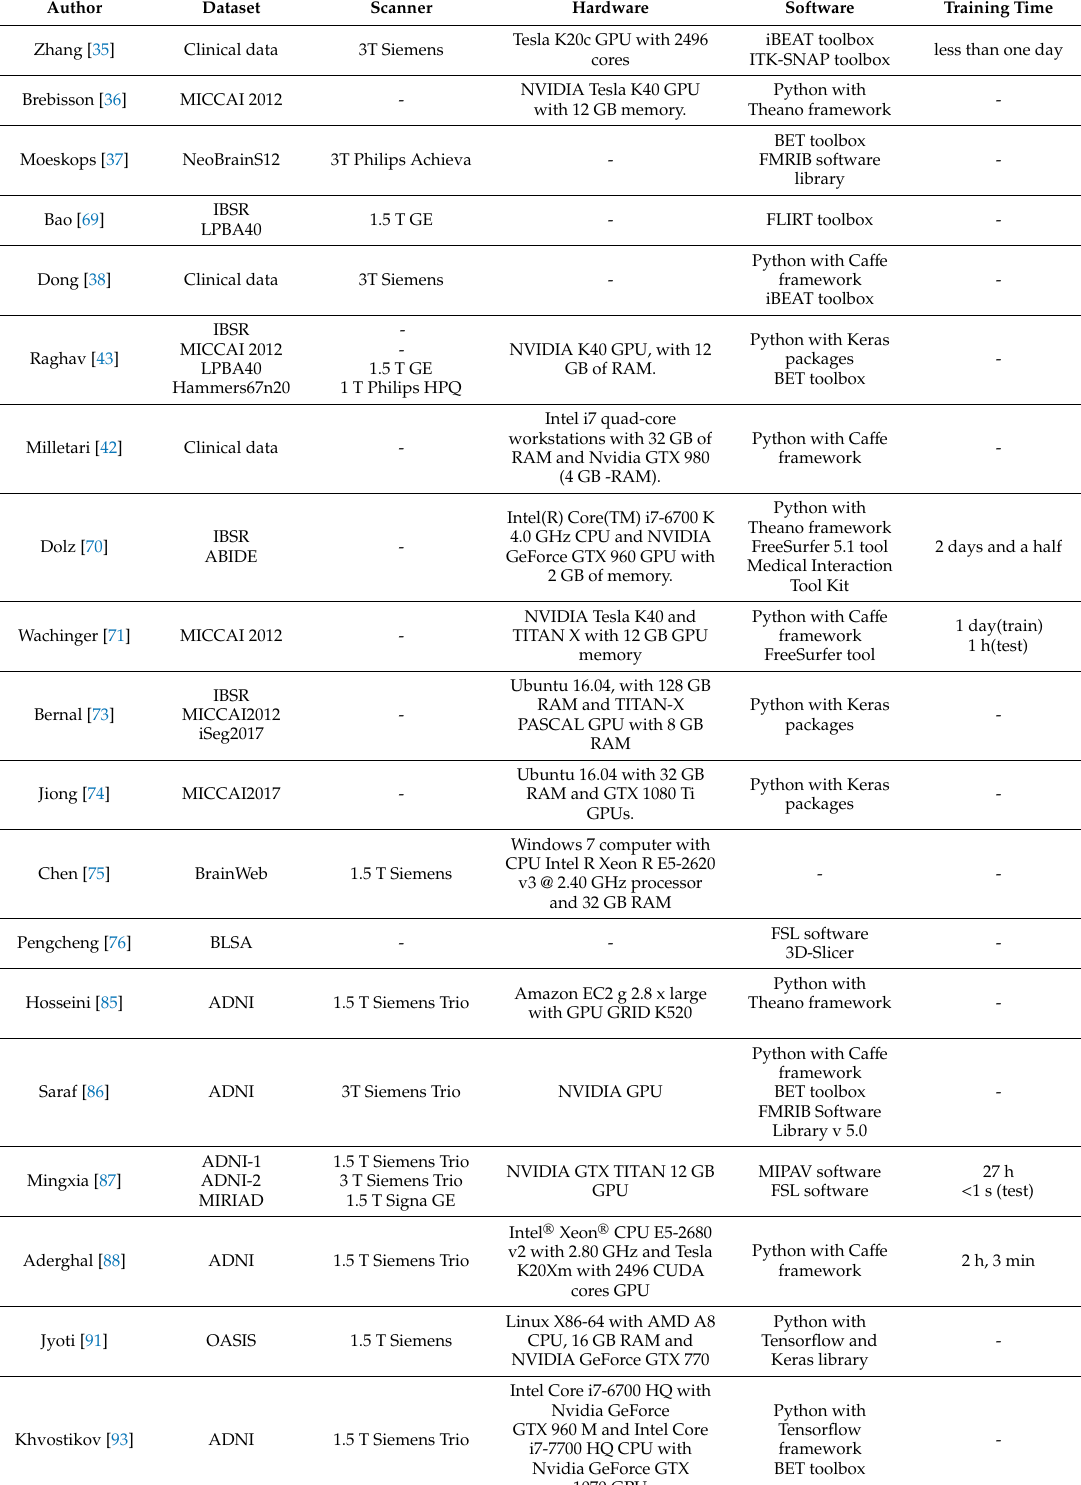
Table 10. Summary of the hardware and software details required for the segmentation of brain MRI and classification of AD using deep learning